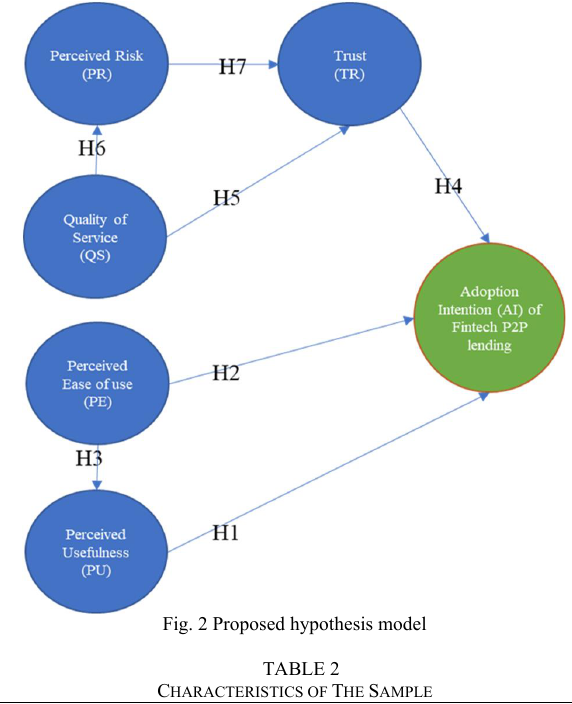
Fig. 2 Proposed hypothesis